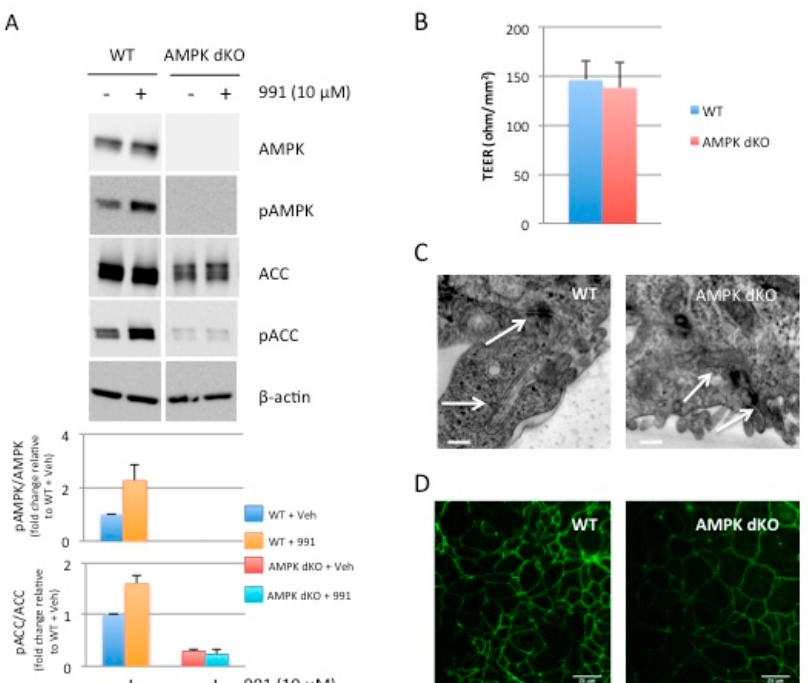
Figure 2. Effect of AMPK deletion on tight junction integrity at steady-state. ( A ) Whole cell lysates of WT and AMPK dKO Caco-2 cells treated with 10 µM 991 for 10 min were analyzed for total and phospho(p)-AMPK and -ACC at Thr-172 and Ser-79, respectively. Expression of β -actin served as loading control. Lower panels represent ratios of pAMPK:AMPK and pACC:ACC from quantification of immunoblot images. ( B ) Variation of trans-epithelial electrical resistance (TEER) in polarized confluent WT and AMPK dKO Caco-2 cells. Cells were grown on Transwell filters for 3 weeks and TEER was measured in WT and AMPK dKO Caco-2 cells. Data represent means ± SD ( n = 3). ( C ) Transmission electron micrograph of WT and AMPK dKO Caco-2 cells at steady-state. Sections of monolayers of postconfluent stationary cells grown on Transwell filters. Arrows indicate cell-cell junctions. High magnification of intercellular spaces with distinguishable tight junctions are shown. Scale Bar: 200 nm. ( D ) Representative immunostaining of ZO-1 in WT and AMPK dKO Caco-2 cells at steady-state. Scale bar: 25 µm.